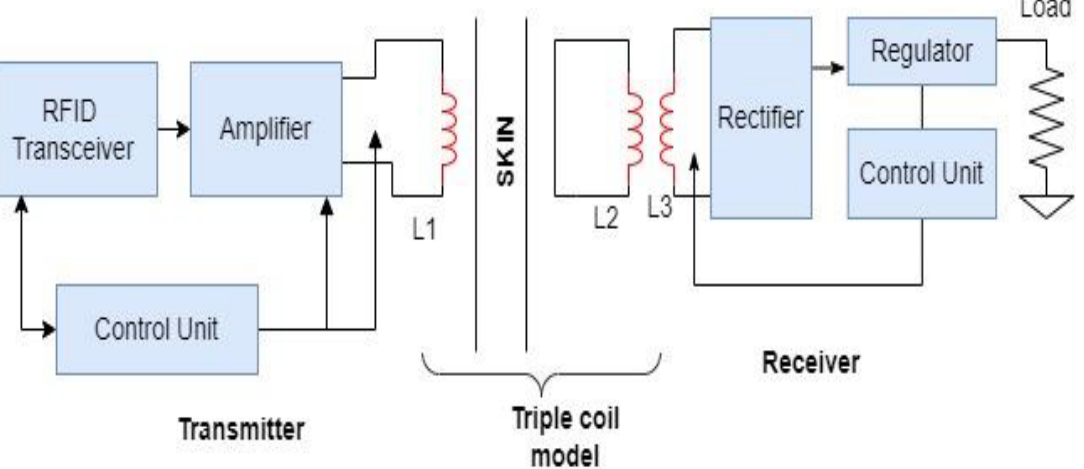
Figure 5. A 3-loop and 3-coil linked inductive WPT transmission.